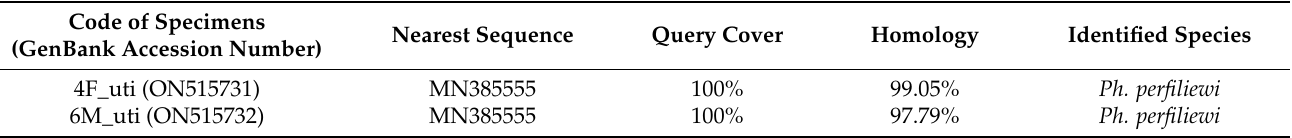
Table 3. Homology (%) between Ph. perfiliewi samples identified in Utique and Saddaguia obtained and the available sequences from the NCBI